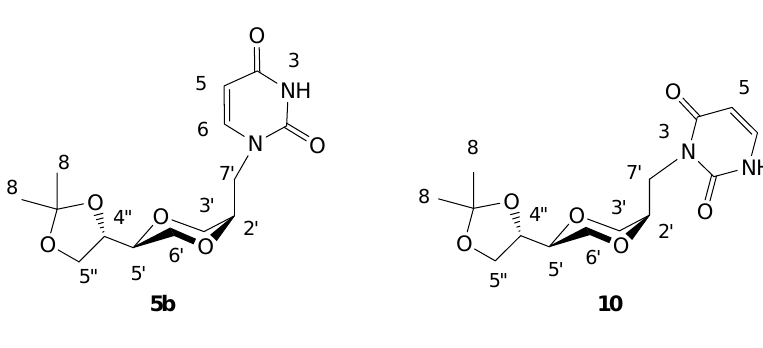
Figure 5. Structures 5b and 10